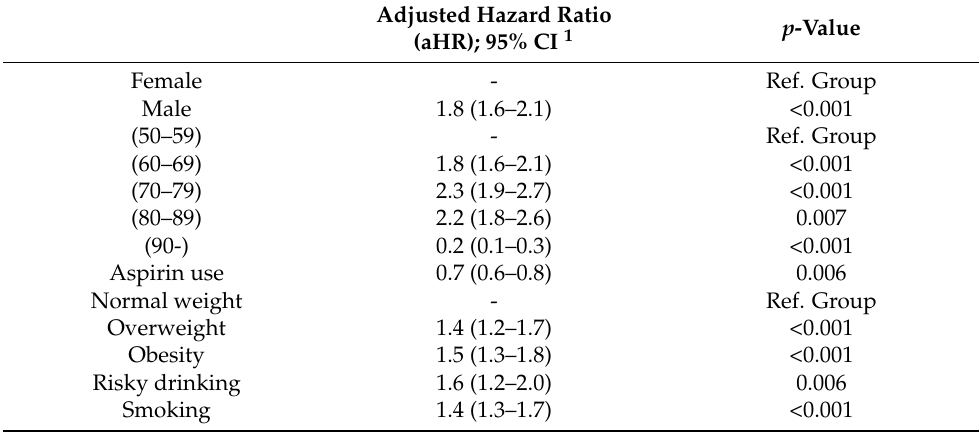
Table 3. Multivariate analysis—Cox